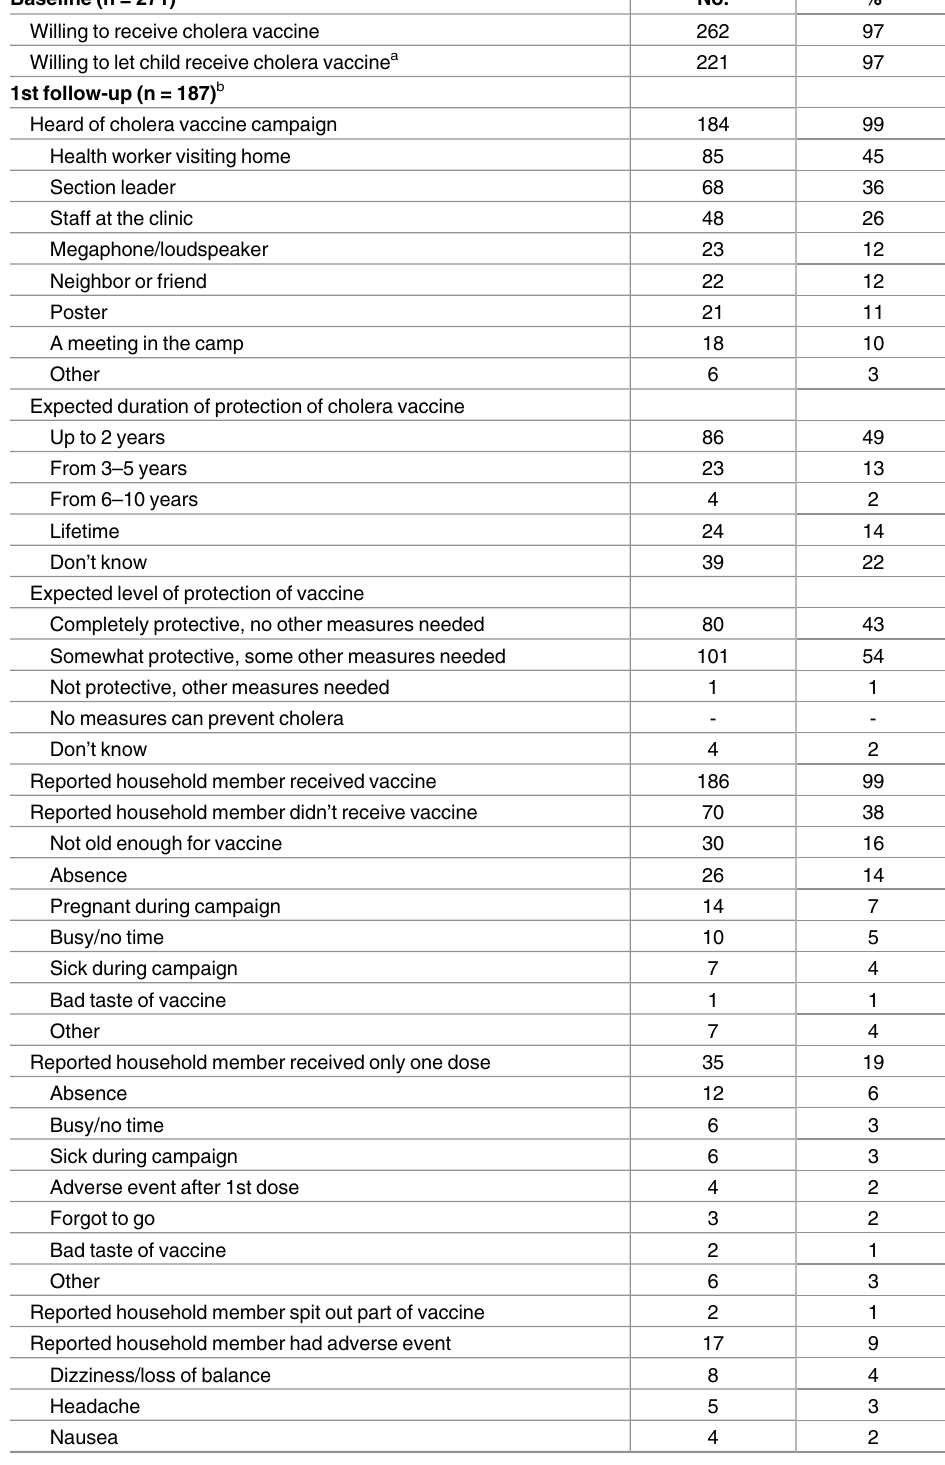
Table 5. Oral cholera vaccination (OCV) acceptability 1 month before the campaign (baseline) and campaign awareness and OCV uptake 3 months after the campaign (first follow-up), Maela Camp, 2013. Baseline (n = 271) No.